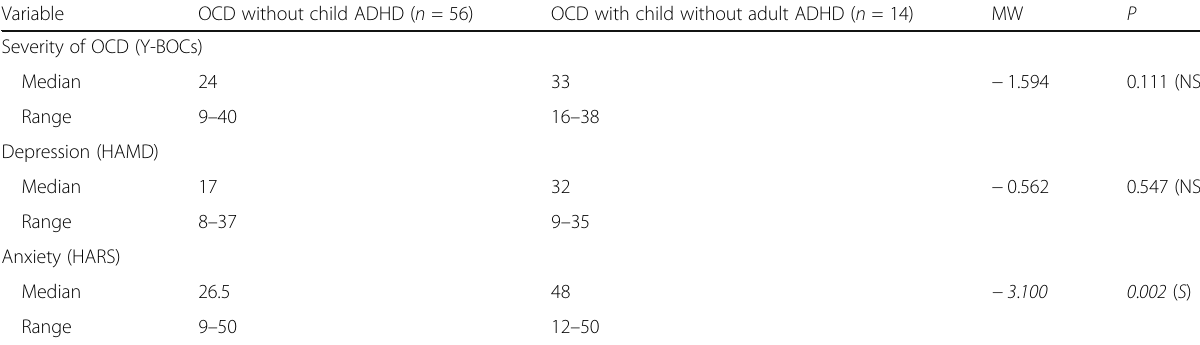
Table 4 Relationship between severity of OCD, depression, anxiety, and child ADHD among the studied groups Variable OCD without child ADHD ( n =